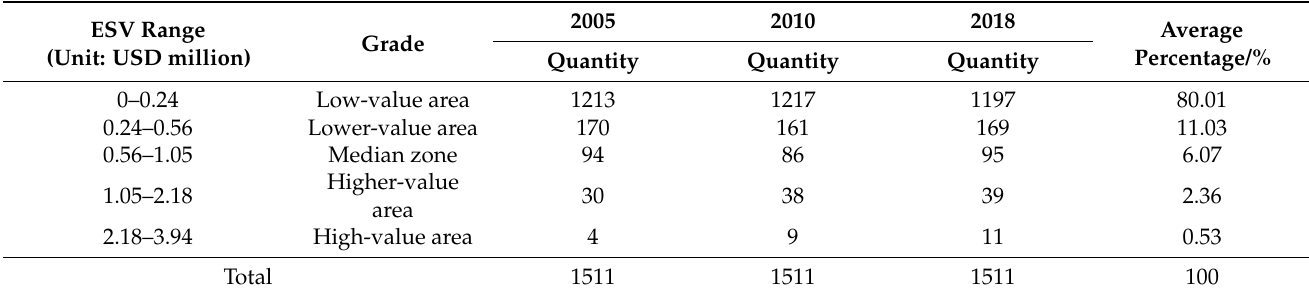
Table 6. The number and proportion of different grading zones of